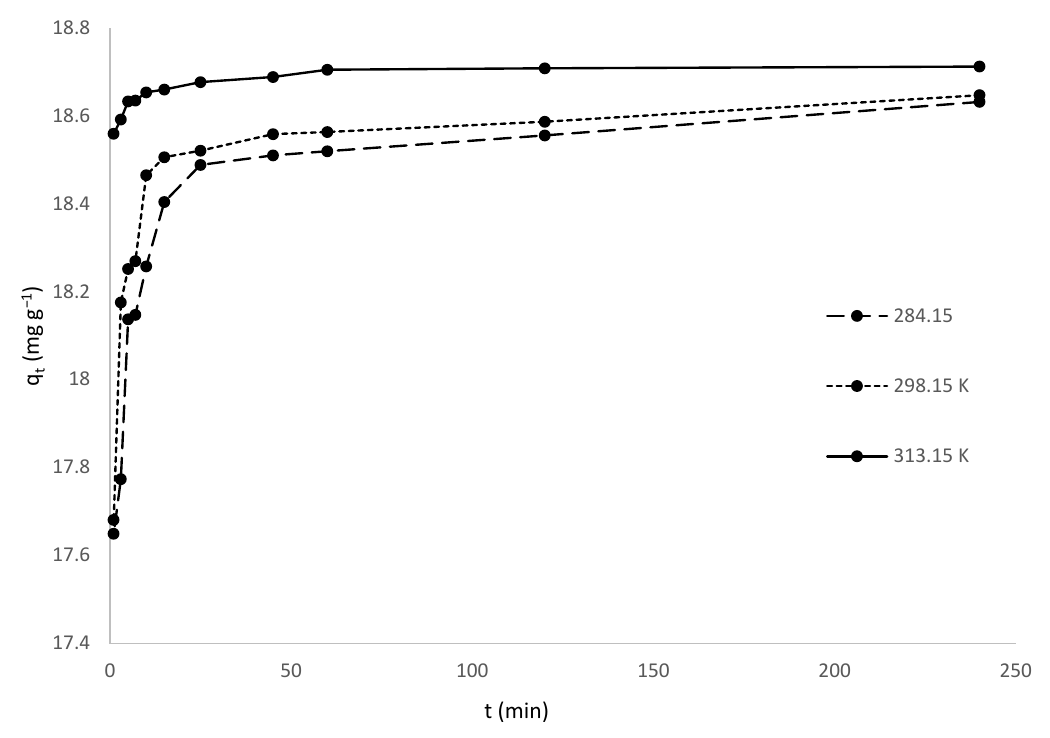
Figure 5. Effect of temperature on adsorption of MV onto HNC.